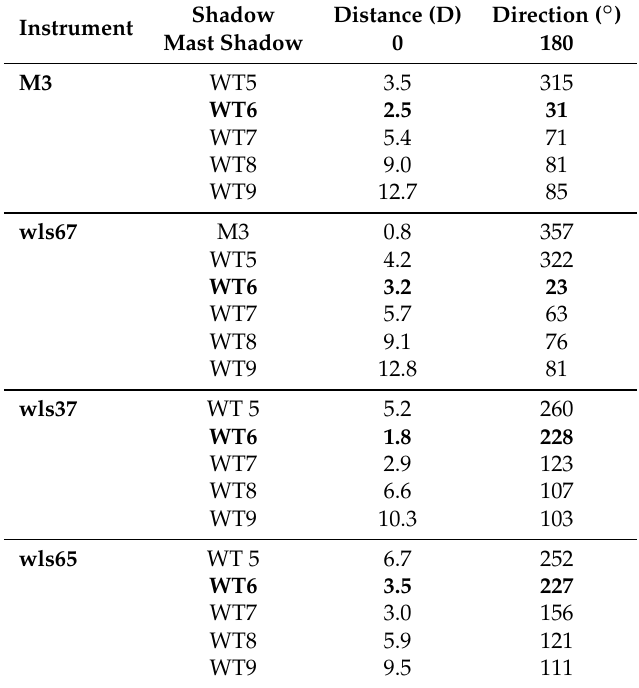
Table 1. Location of the three Windcubes v1 used in this study with respect to expected wakes of the different Wind Turbines (WT5 to WT9) and the Met-mast (M3). The table presents the distance to the corresponding obstacle in rotor Diameters (D) related to the most affected wind direction. The information related to Wind Turbine Number 6 is highlighted in bold letters. Instrument